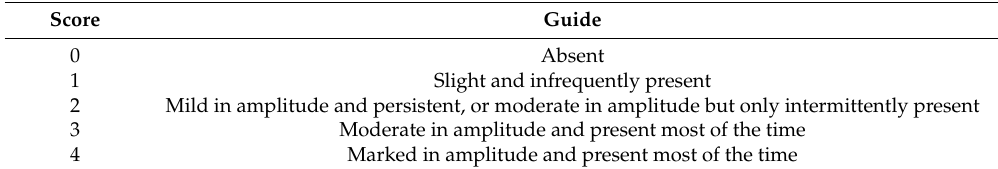
Table 1. Unified Parkinson’s Disease Rating Scale (UPDRS) for a tremor at rest (head, upper, and lower